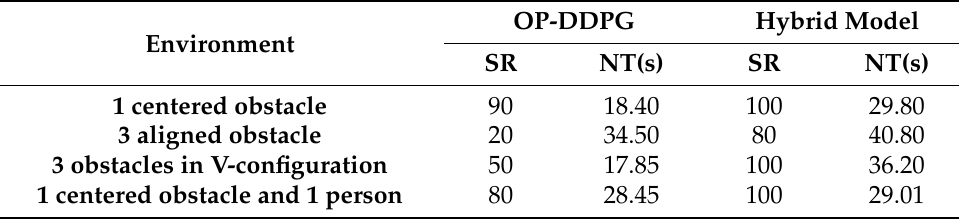
Table 3. OP-DDPG and Hybrid Model comparison for real-life experiments in the three